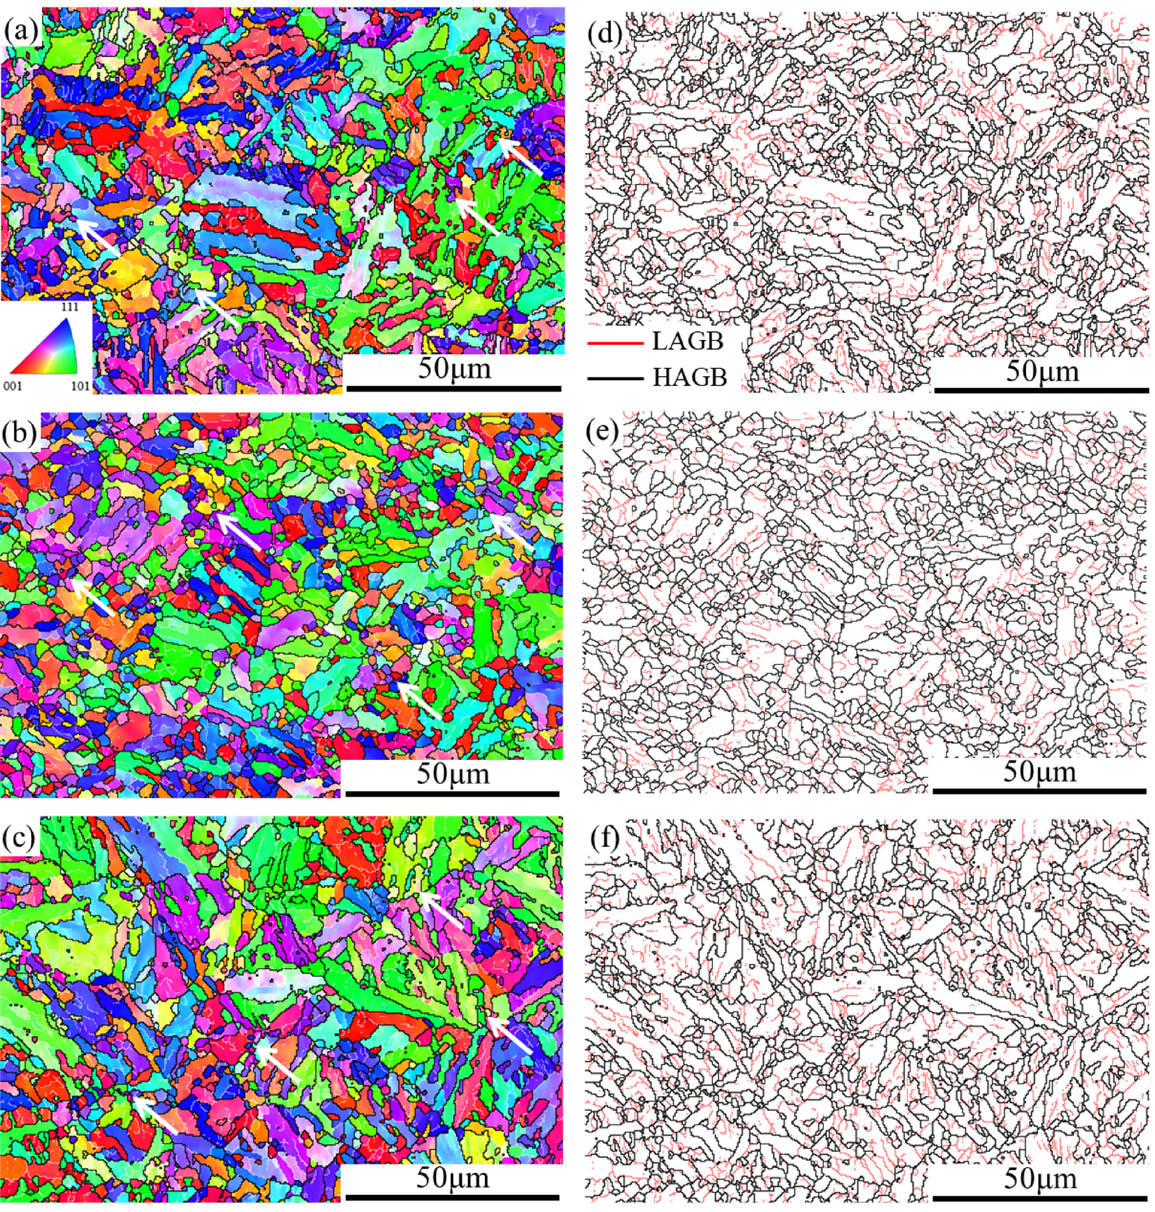
Figure 3. The EBSD maps and misorientation of the grain boundaries at varying compression conditions. ( a , d ) T = 1000 °C, 𝜀(cid:4662) =0.1 s − 1 ; ( b , e ) T = 1100 °C, 𝜀 (cid:4662) = 0.1 s − 1 ; ( c , f ) T = 1000 °C, 𝜀 (cid:4662) = 1 s − 1 .